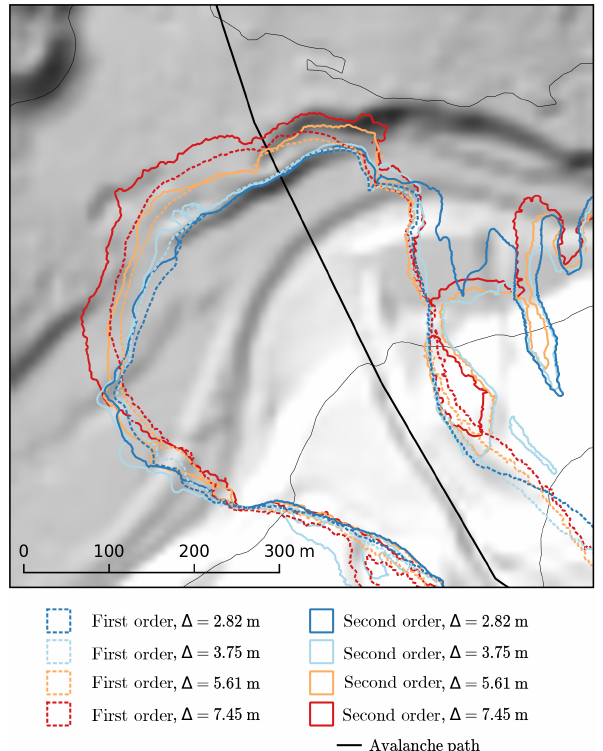
Figure 8. Mesh refinement and convergence study for the Open- FOAM solver. Four mesh sizes and both interpolation schemes, first-order upwind (dashed line) and second-order Gamma (solid line) have been evaluated. The central avalanche path from Fischer et al. (2015) is shown in black. Terrain data: AdTLR.